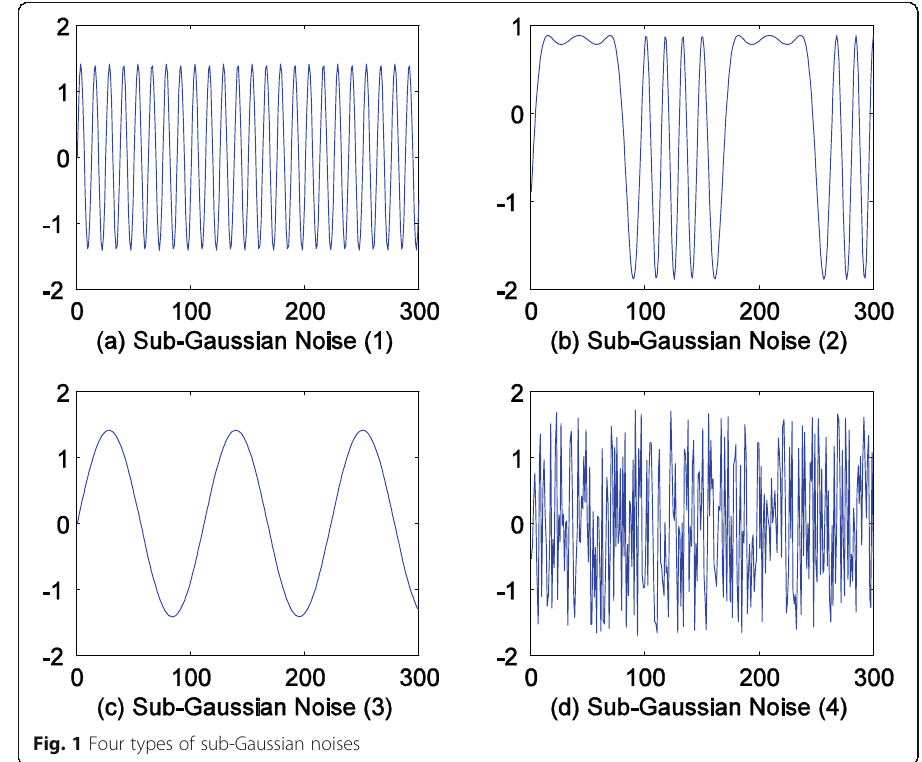
Fig. 1 Four types of sub-Gaussian noises